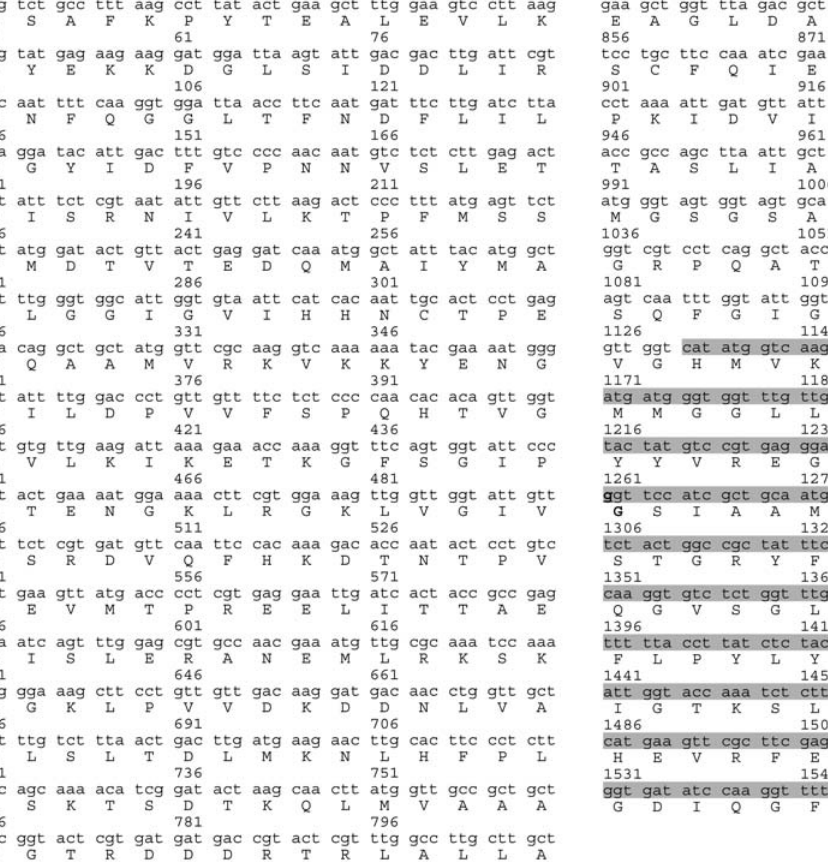
Figure 2 - The sequence of the Schizosaccharomyces pombe gua1 gene showing the predicted inosine monophosphate dehydrogenase (IMPDH) amino acid residues. The cloned and complemented partial gua1 gene discovered in this study is shadowed. The location of the point mutation is shown in bold- facedtype.Alteringtheguanine(g)atthe1261nucleotidepositiontoadenine(a)causedtheIMPDH421 Gly residuetobesubstitutedbya421 Ser